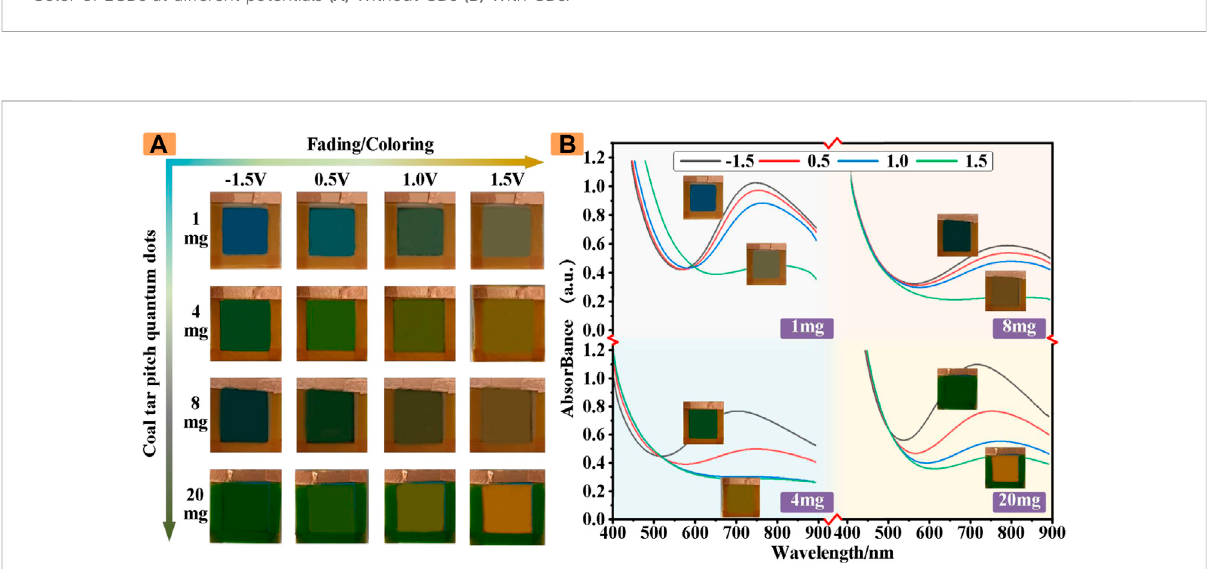
FIGURE 3 Color of ECDs at different potentials (A) Without CDs (B) With CDs.